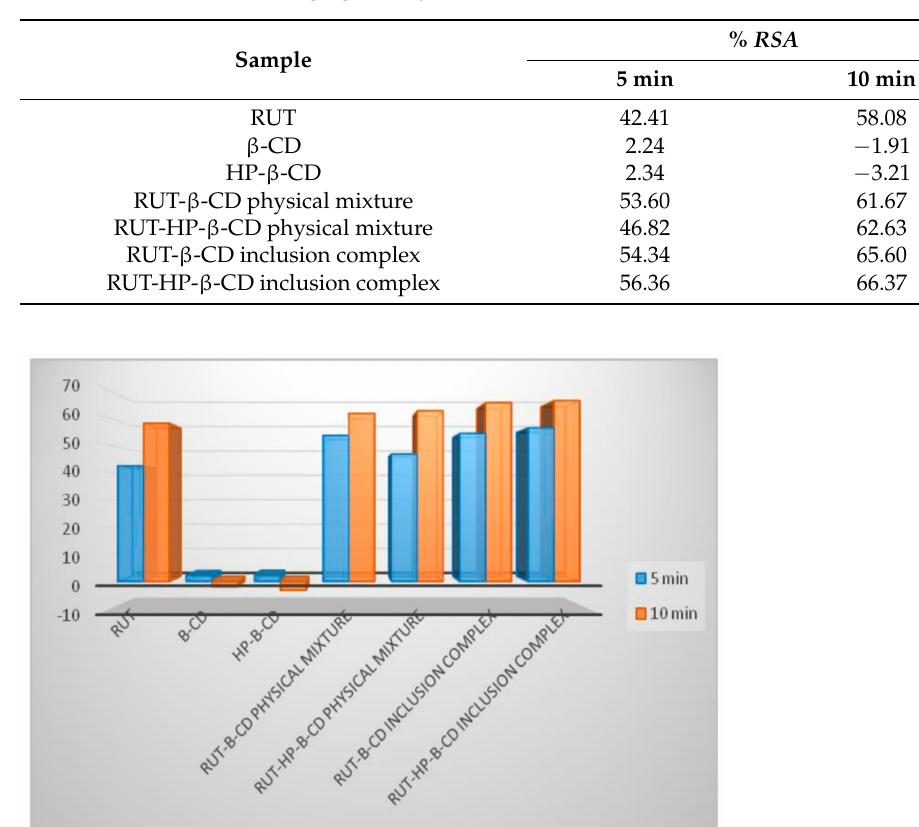
Table 4. ABTS radical scavenging activity.